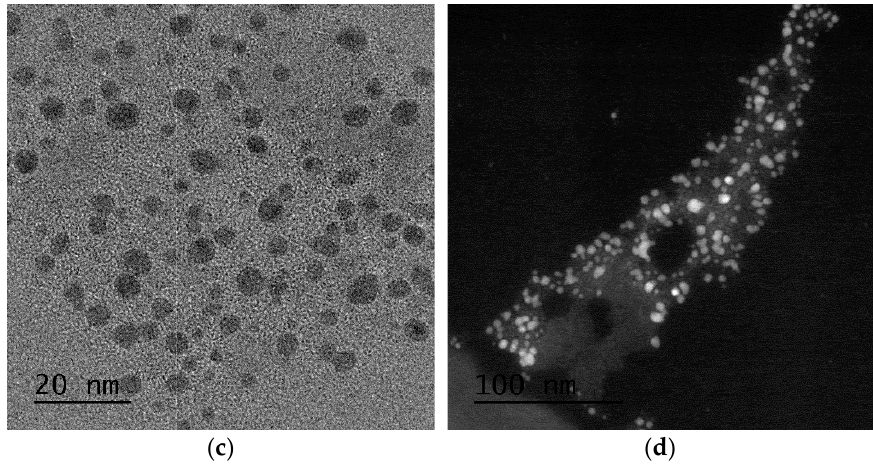
Figure 10. ( a , b ) STEM images in which the amorphous phase of silica with larger particle size and smaller rare earth oxide particles are distinguishable. ( c ) Bright-field and ( d ) HAADF images show that the oxide nanoparticles contain much heavier atoms than the matrix.